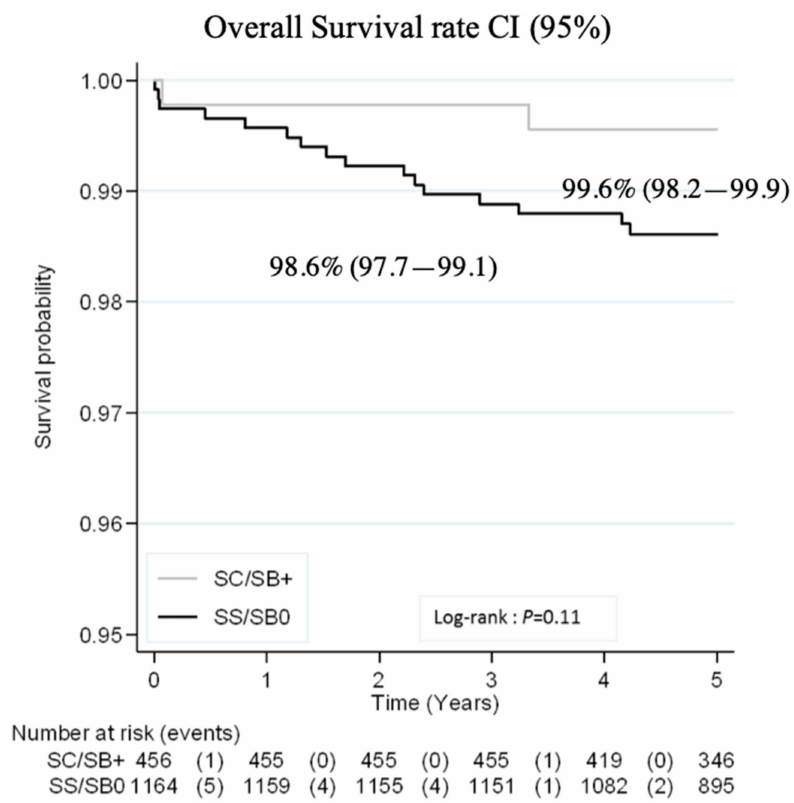
Figure 2. Probability of survival by five years of